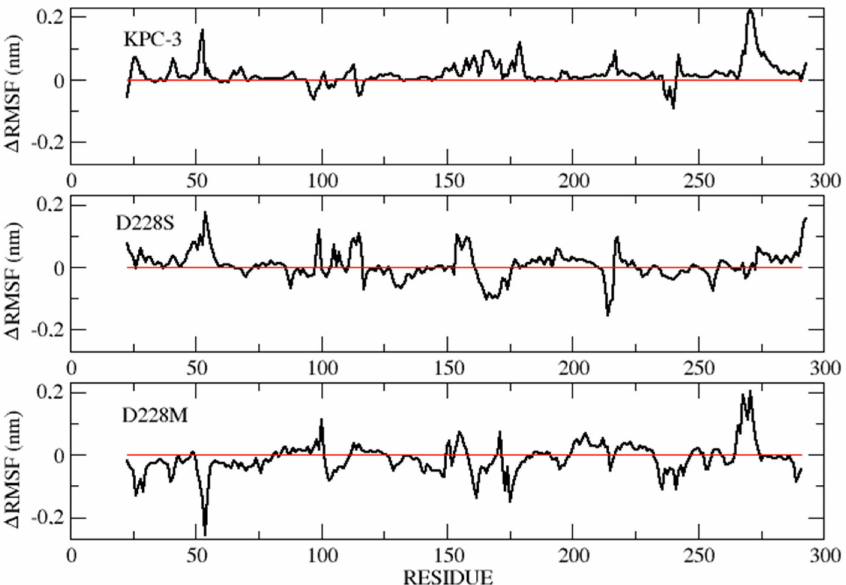
Figure 4. Di ff erence between the complexed and uncomplexed Root Mean Square Fluctuation pattern in the three systems.